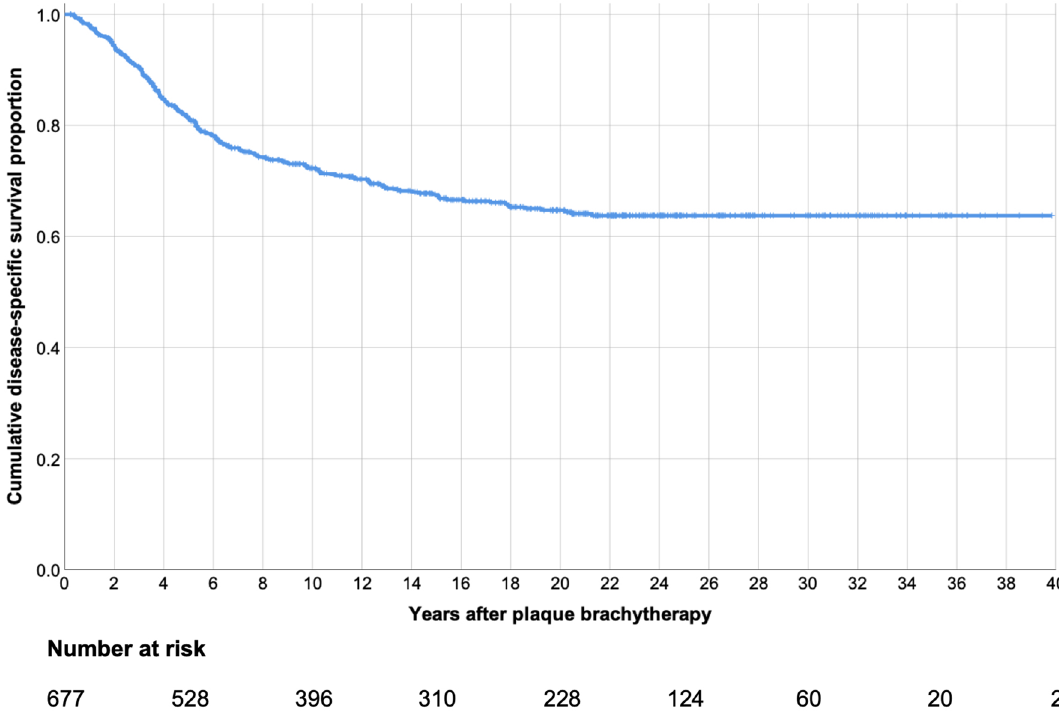
Figure 1. Kaplan–Meier curve, cumulative disease-specific survival proportion after plaque brachytherapy of uveal 1 year, 82% at 5 years, 72% at 10 years, 68% at 15 years, 65% at 20 years and 64% at 25 to 40 years. Median overall survival was 12.3 years (95% CI 10.7–13.9, Fig. 2). Relative survival rates. The observed survival proportions of patients with uveal melanoma were 97% at 1 year after plaque brachytherapy. 73% at 5 years after plaque brachytherapy, 55% at 10 years, 43% at 15 years, 31% at 20 years, 23% at 25 years, 19% at 30 years, 16% at 35 years and 14% at 40 years. The expected survival pro- portions of persons in the general population with the same sex and age at the same calendar year as our patients were 100% at 1 year after plaque brachytherapy, 99% at 5 years, 86% at 10 years, 67% at 15 years, 50% at 20 years, 33% at 25 years, 23% at 30 years, 14% at 35 years and 7% at 40 years (Fig. 3a). Consequently, the relative survival rates were 97% at 1 year, 74% at 5 years, 64% at 10 years, 64% at 15 years, 62% at 20 years, 70% at 25 years, 83% at 30 years, 114% at 35 years and 200% at 40 years (Fig. 3b, Table 3). Long-term survivors. The 209 of our 677 patients that succumbed to their disease were of a similar age at diagnosis as the 468 patients that survived or died from other causes (62 vs. 61 years, Student’s t-test p = 0.468) and had tumors at similar distance to the optic disc ( p = 0.494), but they had significantly larger tumors (diam- eter p < 0.001, thickness p < 0.001, AJCC T-category p < 0.001) at significantly more advanced anatomic stage (AJCC stage p < 0.001). Out of the originally 677 patients, 373 (55%) survived 10 years or longer after plaque brachytherapy. These patients were significantly younger at diagnosis (Student’s t-test p < 0.001) and had tumors with significantly smaller diameters ( p < 0.001), thinner apical thickness ( p < 0.001) and lower AJCC stage ( p < 0.001) than patients that died within 10 years. Tumor distance to the optic disc was however not significantly different between the groups ( p = 0.566, Table 4a). 212 patients (31%) survived 20 years or longer. Similarly, these were significantly younger at diagnosis ( p < 0.001) and had tumors with significantly smaller diameters ( p < 0.001), thinner apical thickness ( p = 0.033) and lower AJCC stage ( p < 0.001). Tumor distance to the optic disc was not significantly different between the groups ( p = 0.131, Table 4b). 54 patients (8%) had 30 years of follow-up or longer. The remaining 623 were either dead or had shorter follow-up. In contrast to the 10 and 20-year survivor groups, the only significant differences for these patients were the age at diagnosis ( p < 0.001) and tumor diameter ( p < 0.019). Tumor apical thickness, AJCC stage and distance to the optic disc were not significantly different to patients with shorter follow-up (Table 4c). In binary logistic regression with patient age at diagnosis, tumor diameter, tumor thickness, AJCC stage, dis- tance to the optic disc and local recurrence as covariates, patient age at diagnosis (odds ratio 0.96 per increased year, p < 0.001) and tumor diameter (odds ratio 0.84 per increased mm, p = 0.004) but none of the other variables were independent predictors of survival 10 years or longer after plaque brachytherapy. Similarly, patient age